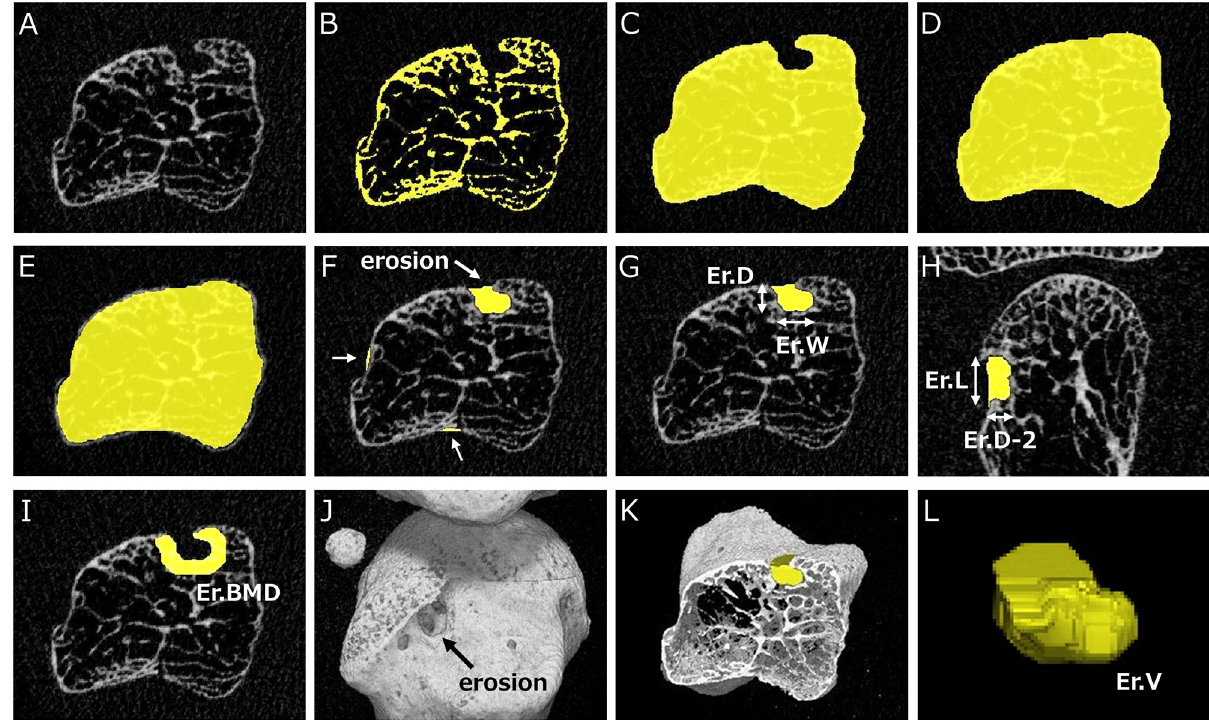
Fig 1. Algorithm for image analysis of erosion parameters for metacarpophalangeal (MCP) joints. A. Gray-scale image of the metacarpal head in the axial view. B. Binarization at a threshold value of 320 mg/cm 3 . C. Filling bone marrow spaces. D. Filling concavities on bone surface. E. Shrinking the contour from Fig 1D by 0.25 mm. F. Extraction of all concavities (white arrows) and detection of erosions based on the false-positive pattern in Fig 2 and the definition from SPECTRA. G. Manual measurement of erosion depth (Er.D) and width (Er.W) in the axial view. H. Manual measurement of erosion depth (Er.D-2) and length (Er.L) in the perpendicular (coronal) view. I. Measurement of peripheral BMD (Er.BMD) surrounding an erosion at a width of 1 mm. J. 3D image of MCH and erosion on the radial side (black arrow). K. Axial section of the 3D image including an erosion. L. Volume of interest (VOI) of an erosion and measurement of erosion volume